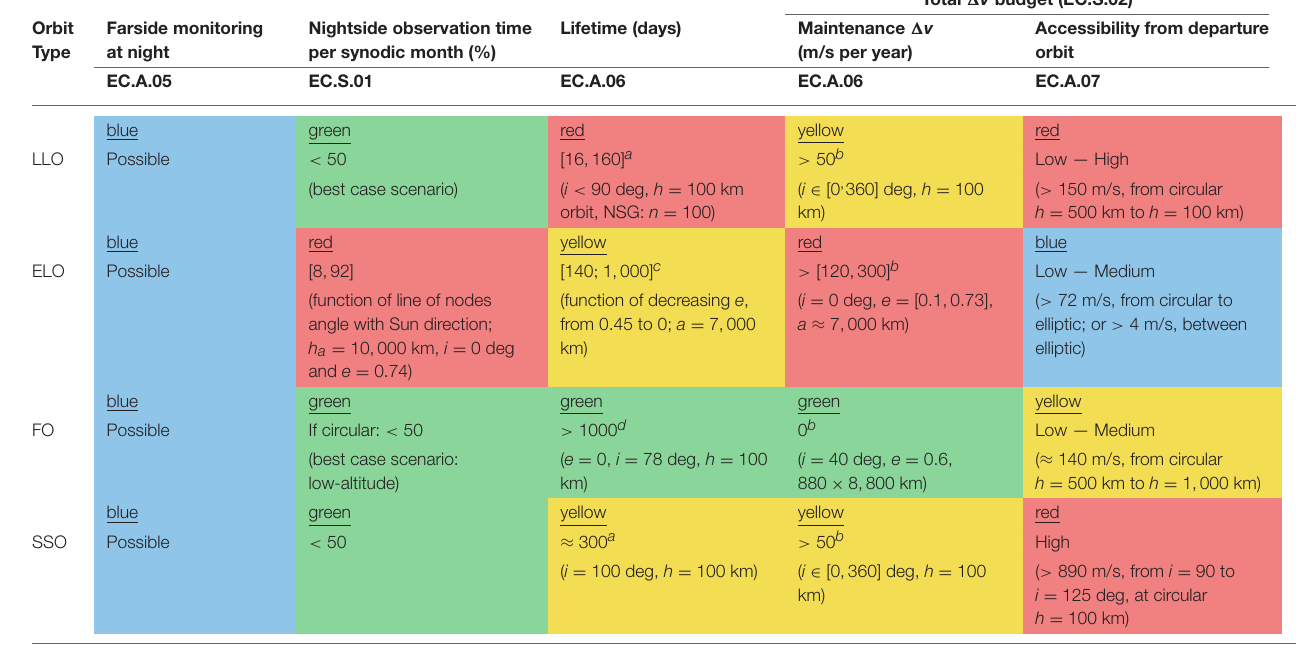
TABLE 5 | Trade-off of (perturbed) Keplerian orbits.